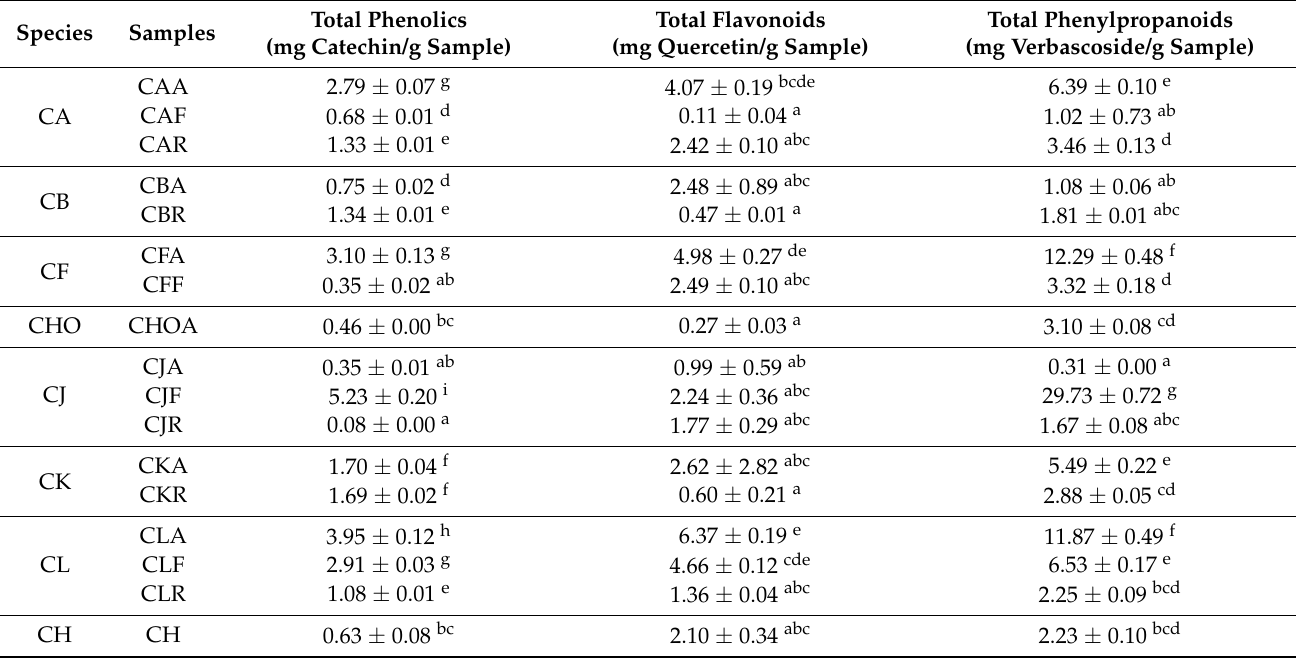
Table 1. The contents of total phenolics, total flavonoids, and total phenylpropanoids of Cirsium species and Cirsii Herb. Species